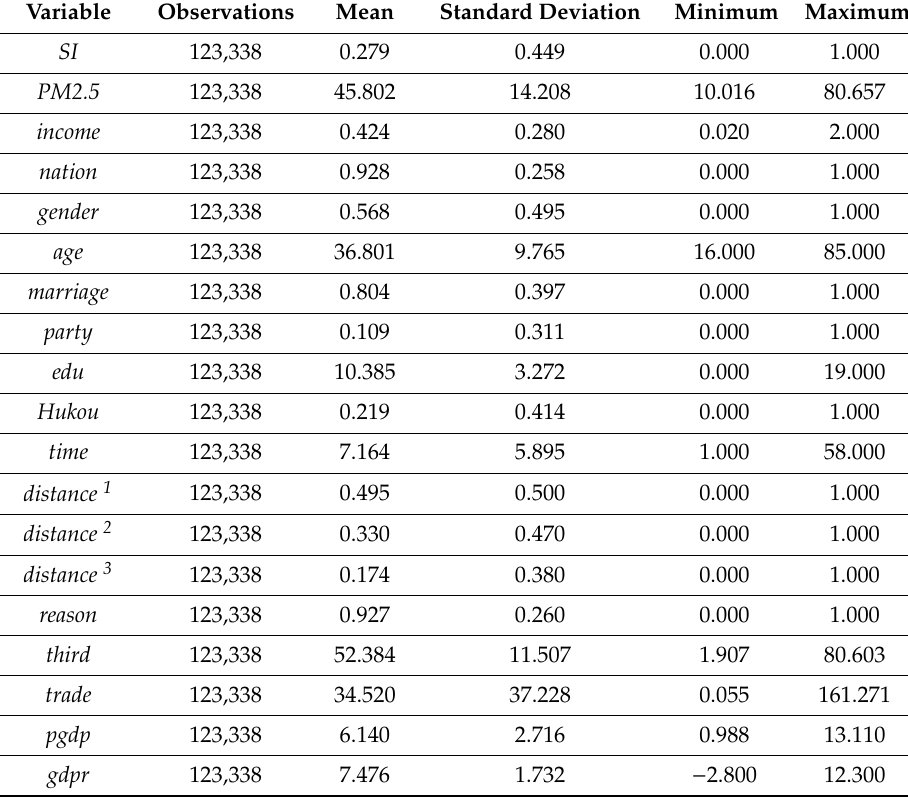
Table 3. Descriptive statistics of the